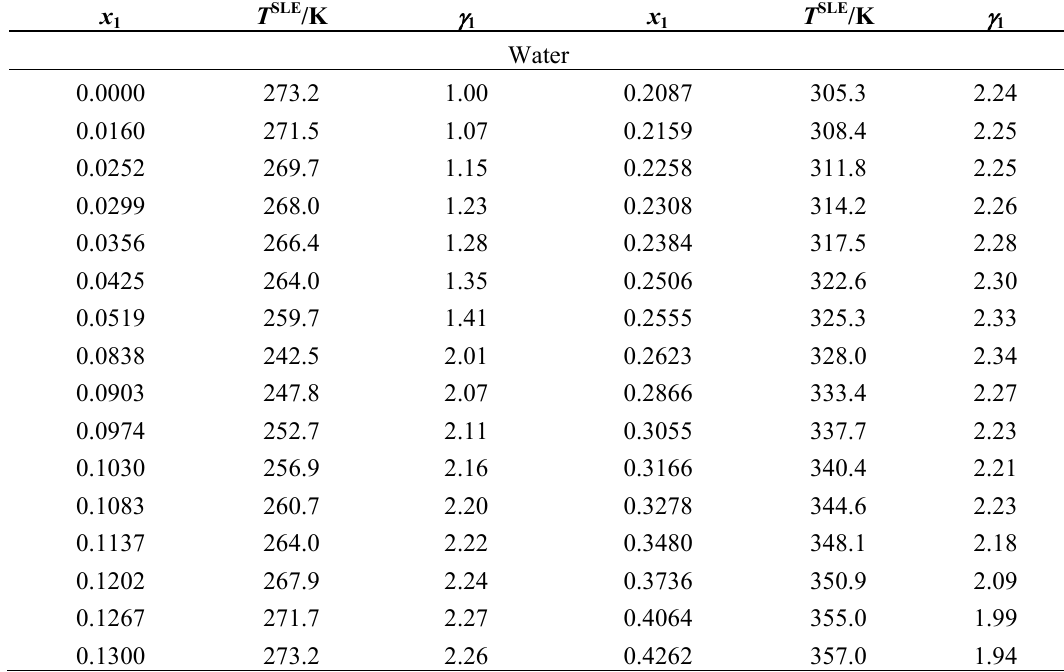
, mole fraction;  , experimental activity coefficient of the 1 1